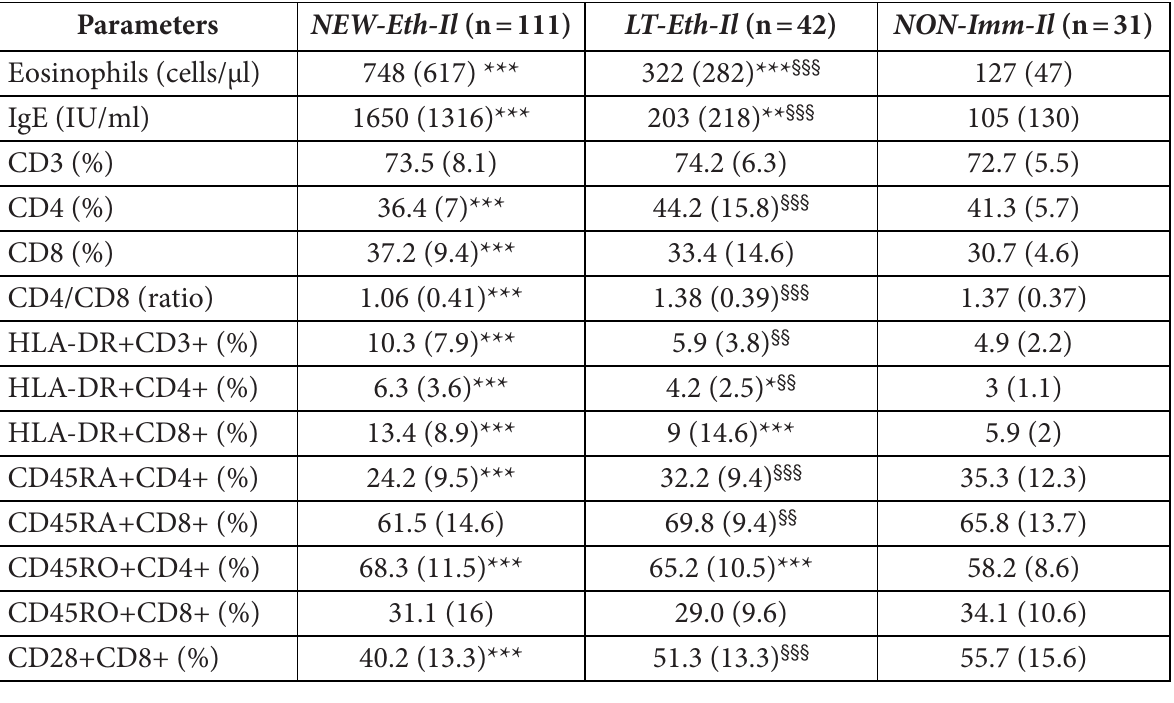
Table 2. Immunological parameters of study groups at baseline: new and long term-Ethiopian im- migrants and non-Ethiopian Israeli